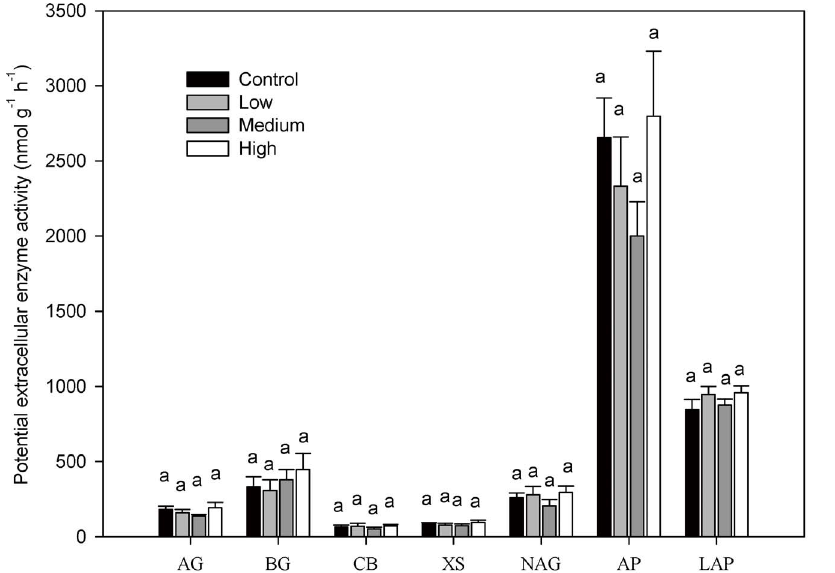
Figure 6. Potential extracellular enzyme activity at a soil depth of 0–10 cm in control and fertilized plots measured in 2012. Significant differences among nitrogen (N) treatments are indicated by different letters. AG = a -glucosidase; BG = b -1,4-glucosidase; CB = b -D- cellobiosidase; XS = xylosidase; NAG = N-acetyl-glucosaminidase; AP = acid phosphatase; LAP = leucine aminopeptidase.